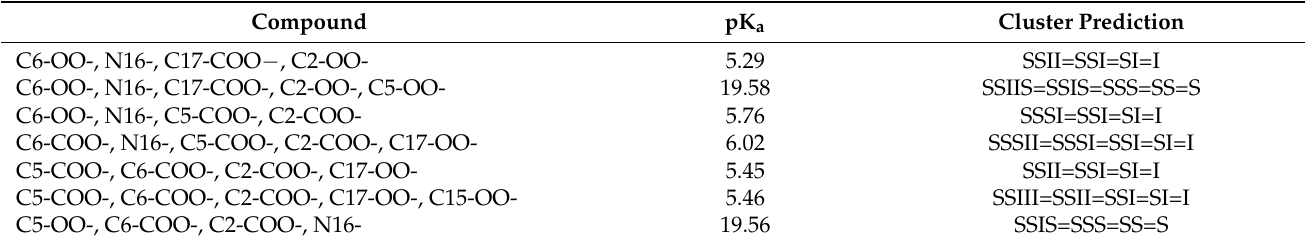
Table 4. Cluster prediction based on the linear model proved in Section